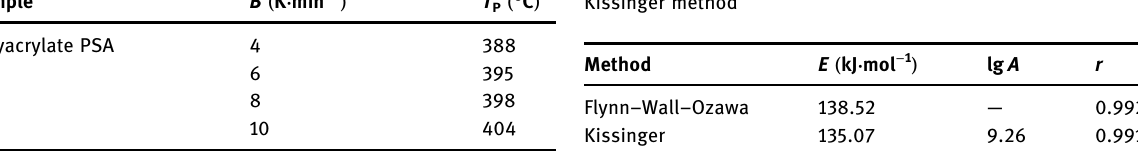
Table 1: Peak temperature of polyacrylate PSA at di ff erent heating rates Sample